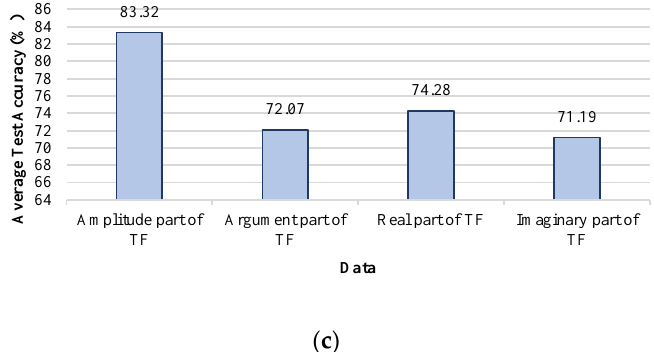
Figure 25. Average performance of models, using indices and parts of the TF in localization of the DSV fault: ( a ) average performance of the GMDH and MLP models; ( b ) average performance when models are trained with the extracted features by different indices; ( c ) average performance of models when the extracted features are from different parts of the TF.